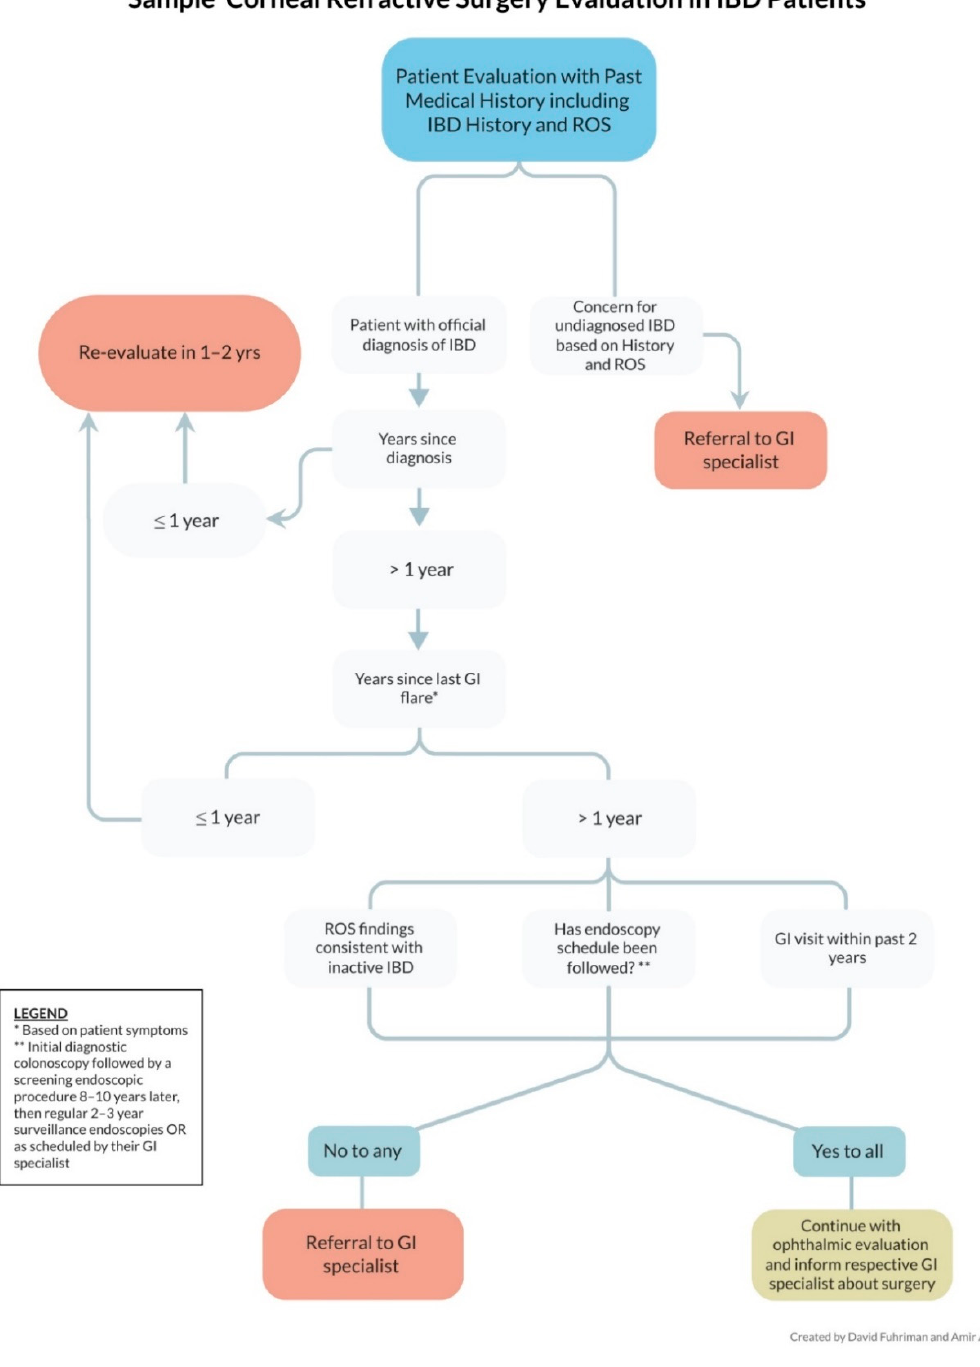
Figure 4. Sample corneal refractive surgery evaluation in IBD patients.